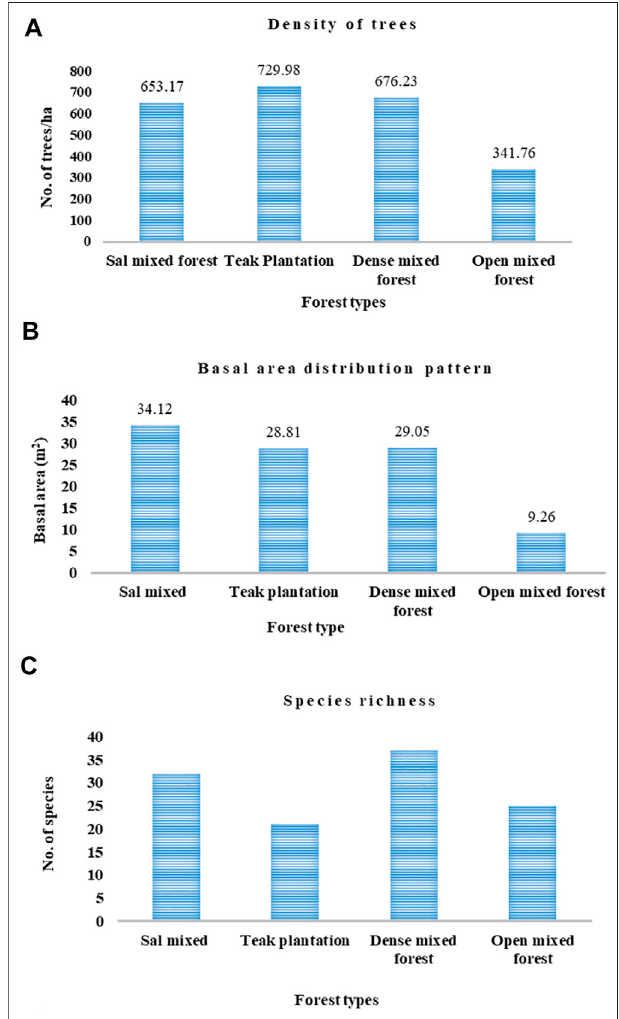
FIGURE 3 | Structural parameters of dry tropical forests of AABR. (A) Density of tree layer, (B) Basal area distribution, (C) Species